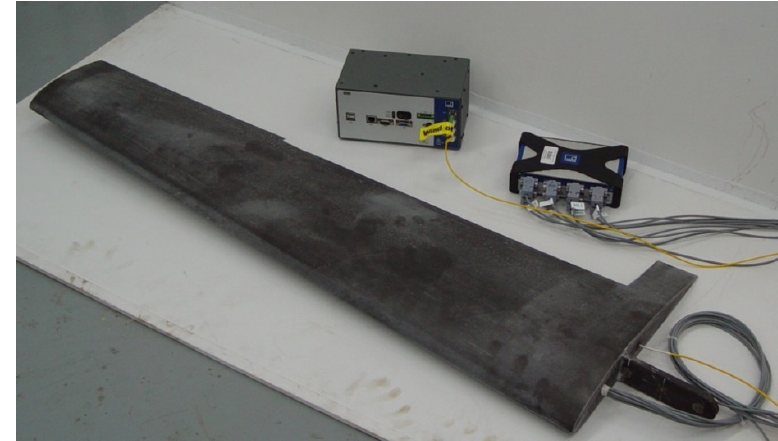
Figure 5. Strain gauges integrated into the wing structure. Aerospace 2020 , 7 , x FOR PEER REVIEW